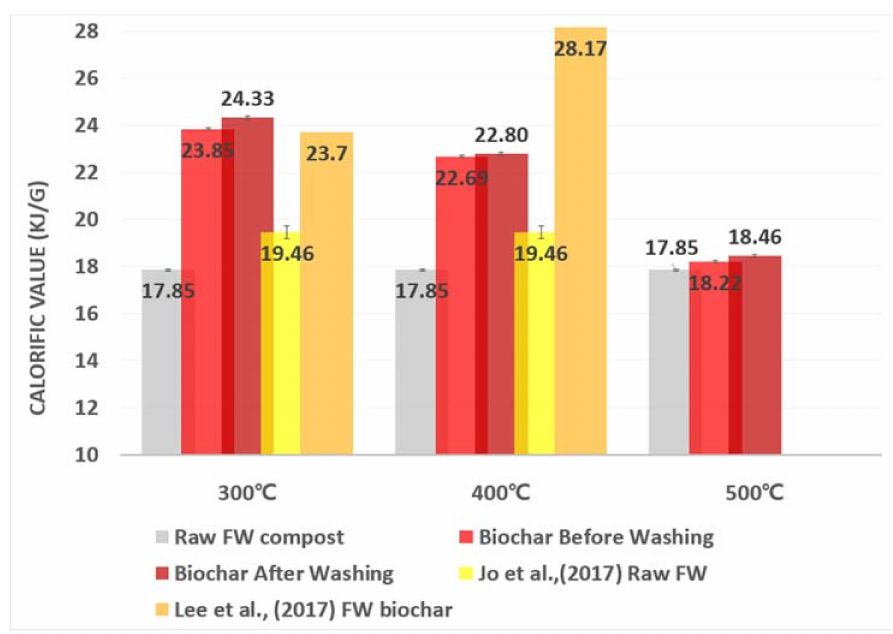
Figure 5. Calorific values of food waste compost biochar and raw